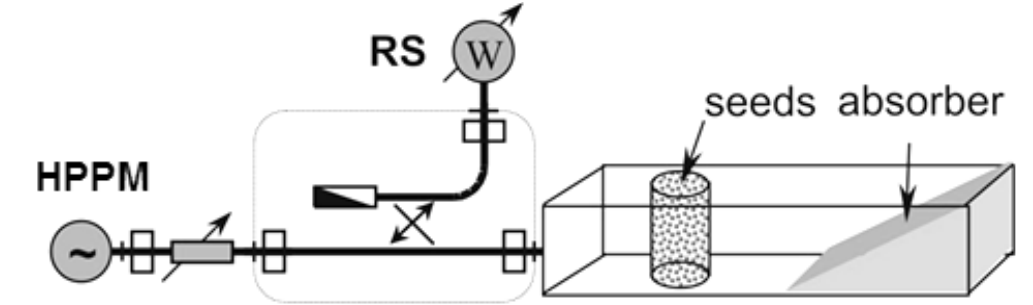
Figure 1. Experimental structure: microwave expose on tomato seeds in the waveguide, where RS is a resistive sensor applied as a transmitted microwave power meter; HPPM—high power pulsed magnetron.